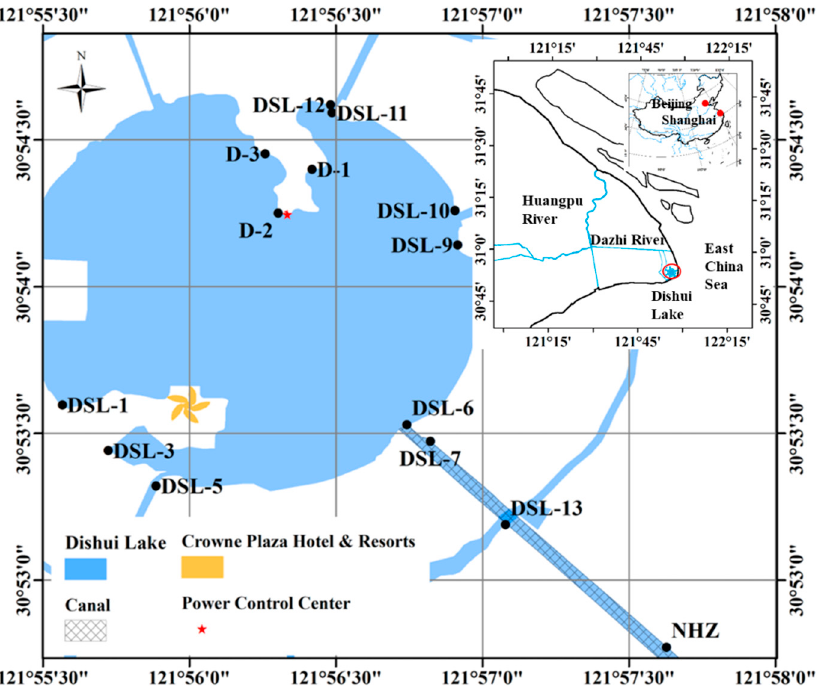
Figure 1. Map showing sampling sites in the Dishui Lake.